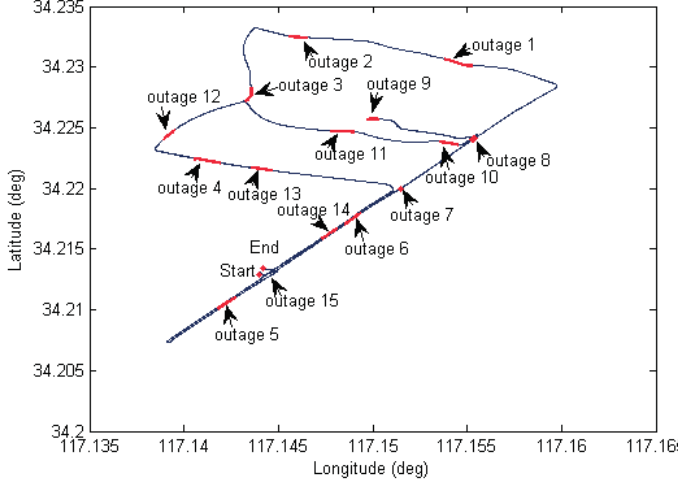
Figure 12. Ground track of test vehicle with simulated GNSS